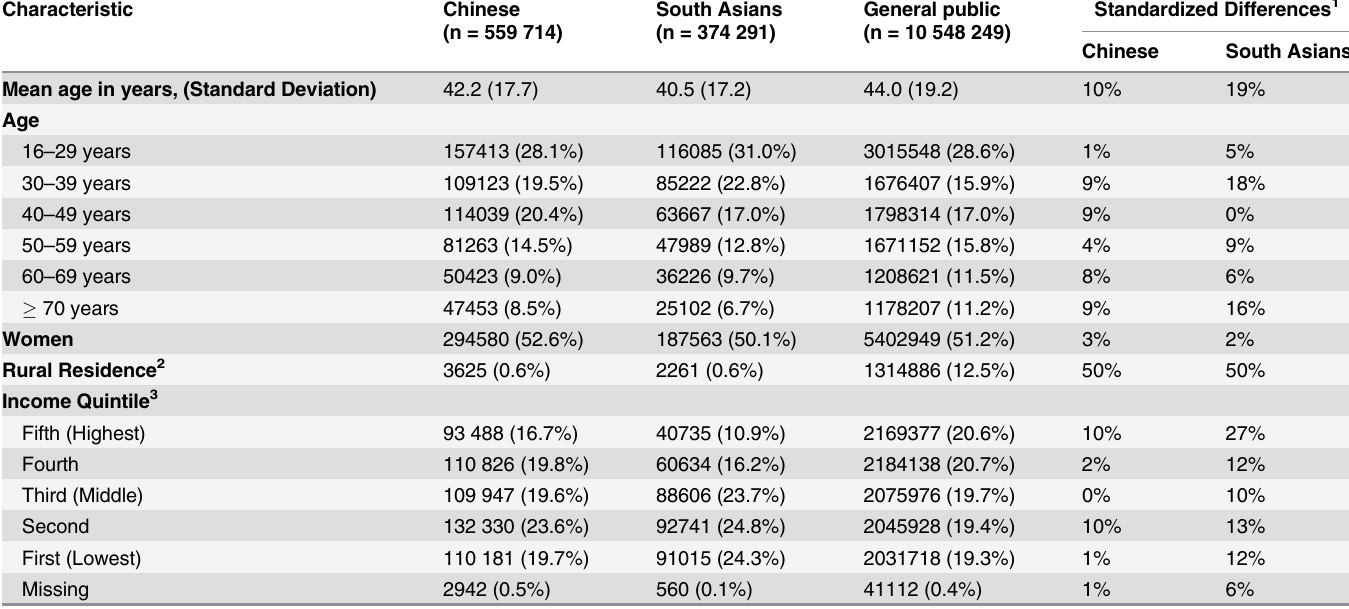
Table 1. Baseline Characteristics of Eligible Registrants (Cross-sectional